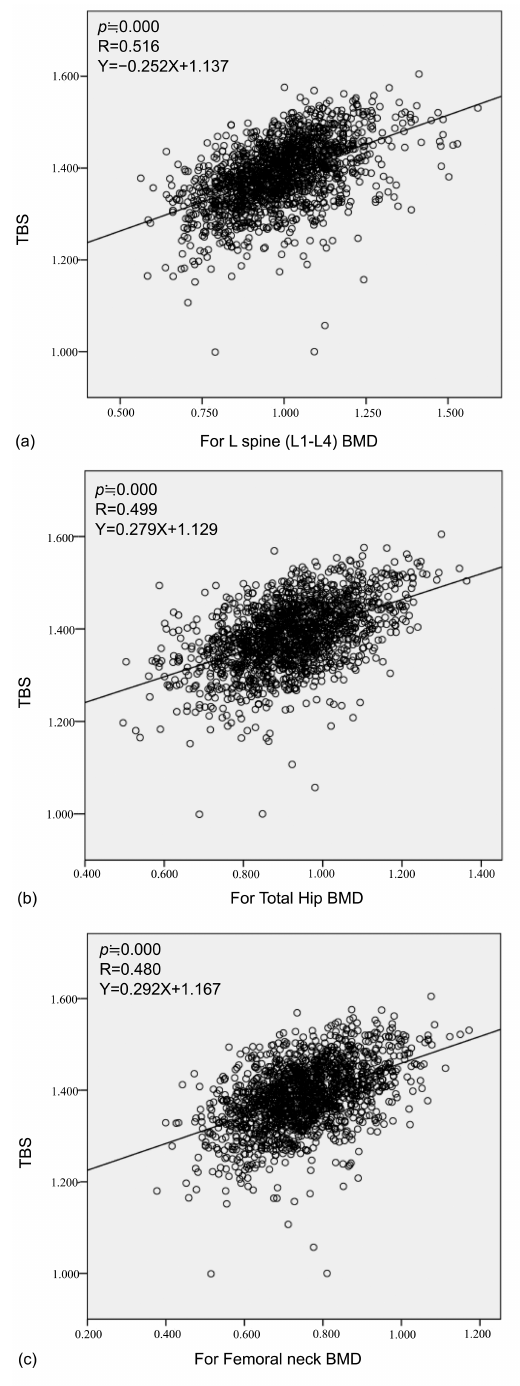
FIGURE 1. TBS regression models. Associations between TBS and (A) spine BMD, (B) total hip BMD, and (C) femoral neck BMD. TBS, trabecular bone score; BMD, bone mineral density; FN, femoral